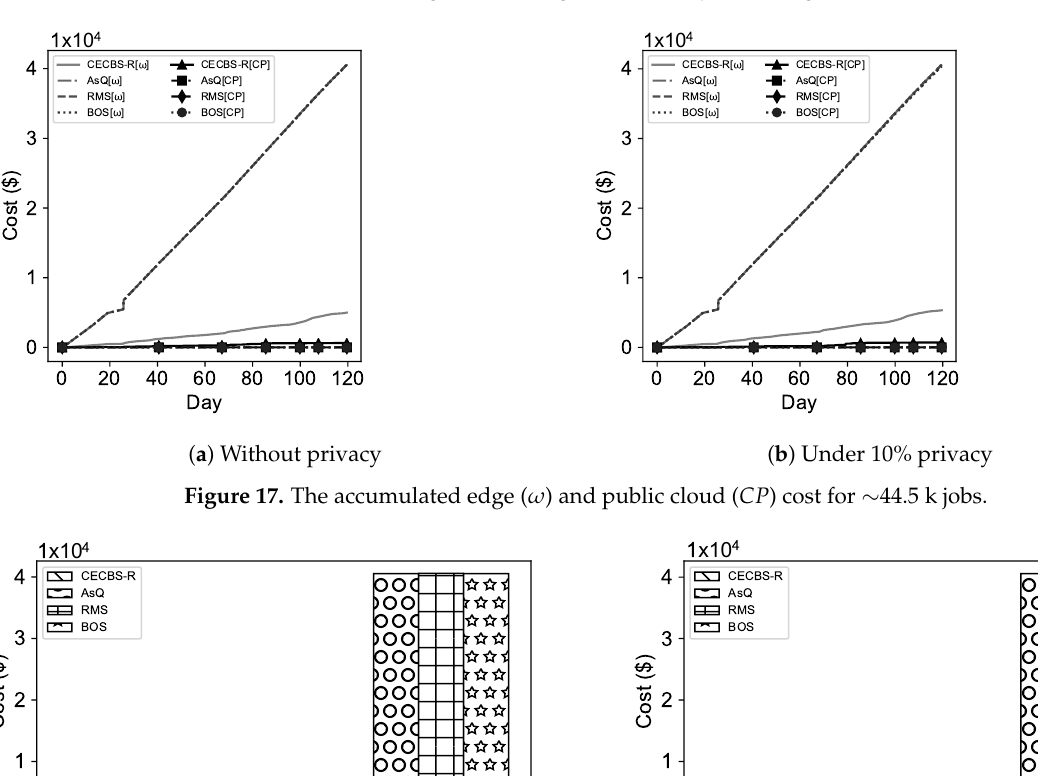
Figure 16. The edge server usage for ∼ 44.5 k jobs during 3 months.